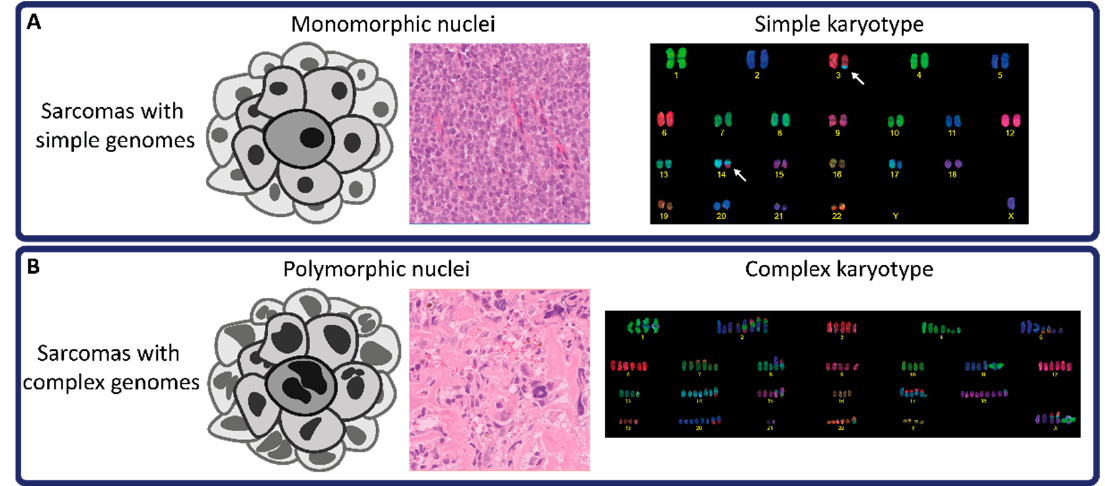
Figure 1. Morphological and karyotypic differences between sarcomas with simple and complex genomes. ( A ) schematic figure and HE staining demonstrating monomorphic nuclei. White arrows in simple karyotype image indicate a translo- cation (3:14), typically observed in translocation-driven sarcomas. ( B ) schematic figure and HE staining demonstrating polymorphic nuclei. The complex karyotype image displays extensive chromosomal aberrations, including chromosomal gains and translocations.